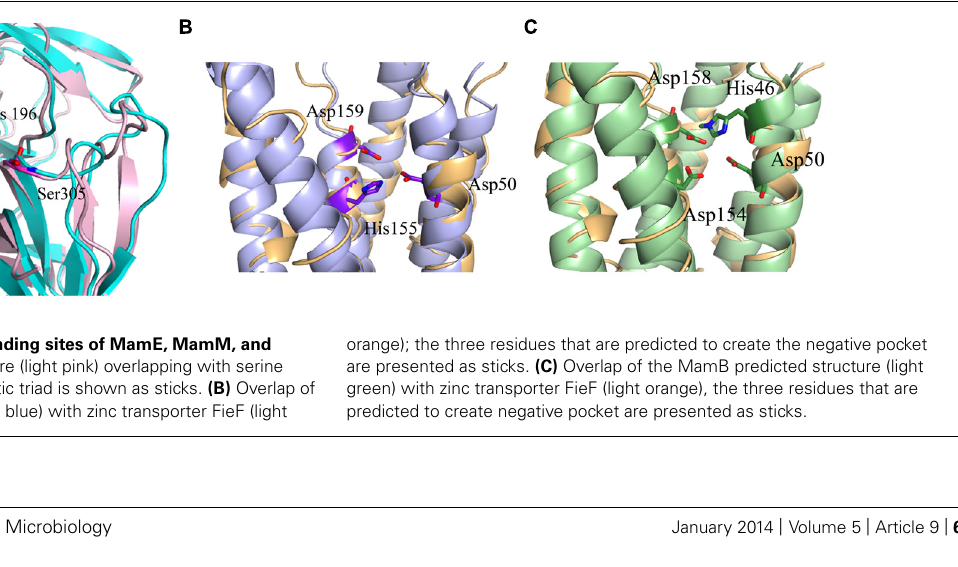
orange); the three residues that are predicted to create the negative pocket are presented as sticks. (C) Overlap of the MamB predicted structure (light green) with zinc transporter FieF (light orange), the three residues that are predicted to create negative pocket are presented as